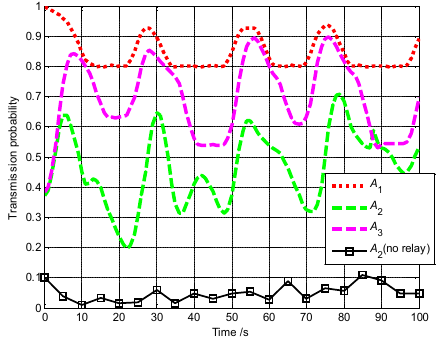
Figure 30. The communication performances of A 1 , A 2 and A 3 (Scenario 3).